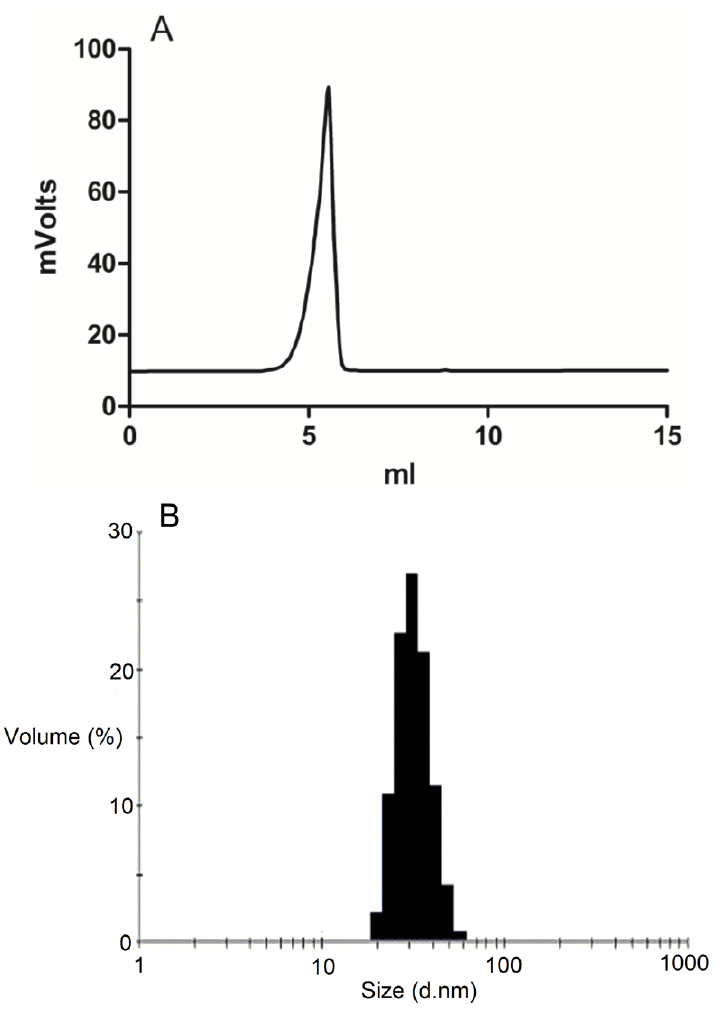
2. ( A ) Gel permeation chromatography (GPC) of ridaforolimus loaded DSPE-PEG micelles in water mobile phase at 0.8 mL/min with evaporative light 2000 scattering detector (ELSD) detection; ( B ) Size distribution of ridaforolimus loaded DSPE-PEG micelles indicating an average diameter of 33 2000